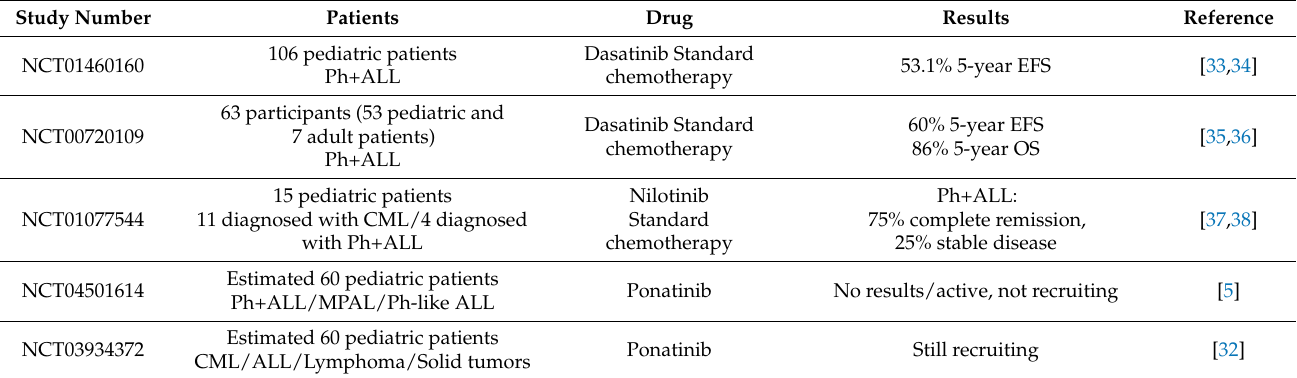
Table 1. Second and third generation tirozin-kinase inhibitors in pediatric